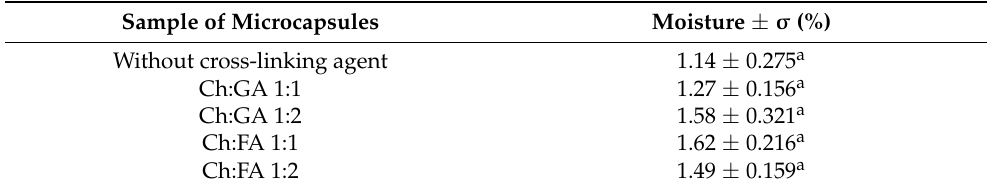
Table 1. The moisture content in samples of the chitosan/sodium dodecyl sulfate (Ch/SDS) micro- capsules. Different superscript letters (within one column) represent significant differences ( p < 0.05), as obtained by ANOVA and Tukey’s HSD test.